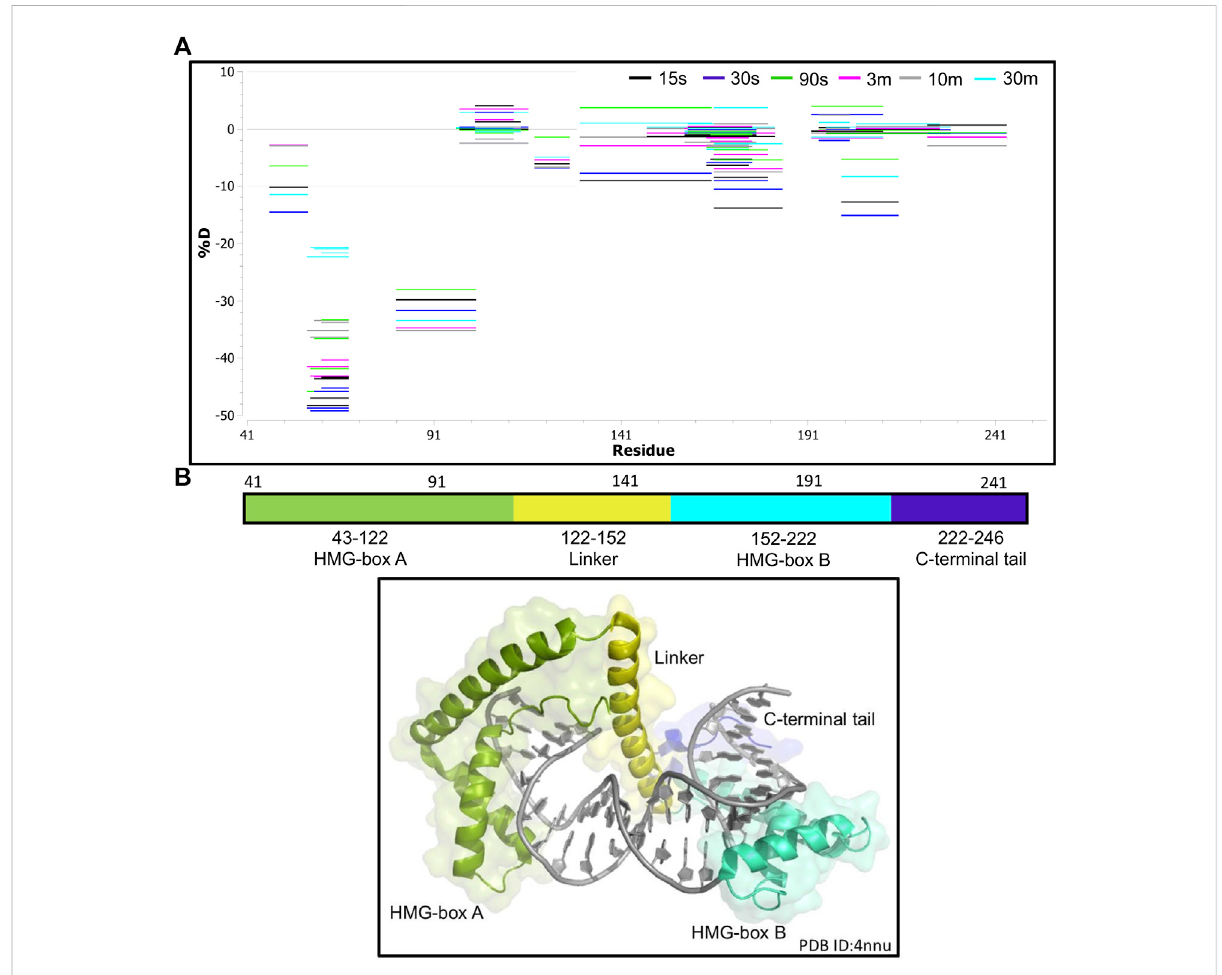
FIGURE 4 Hydrogen-deuterium exchange of the TFAM-DNA complex reveals the regions of TFAM involved with DNA binding. (A) Woods plot representing the distribution of TFAM regions displaying differential levels of solvent protection in the presence of DNA. Percent change in deuteration for peptides after various time points (15 s – 30 m) between TFAM and the TFAM-DNA complex, where a negative percentage indicates less deuteration and more protection due to complex formation with the DNA. Each horizontal line in the plot represents an individual peptide with residue range on the X -axis and deuteration level i.e., level of protection on the Y -axis. (B) The domain map and cartoon representation of the crystalstructureoftheTFAM-DNAcomplex(PDBID:4nnu)aredisplayed.Inthestructure,theDNAiscoloredgreyandeachregioniscolor-matched to the domain map